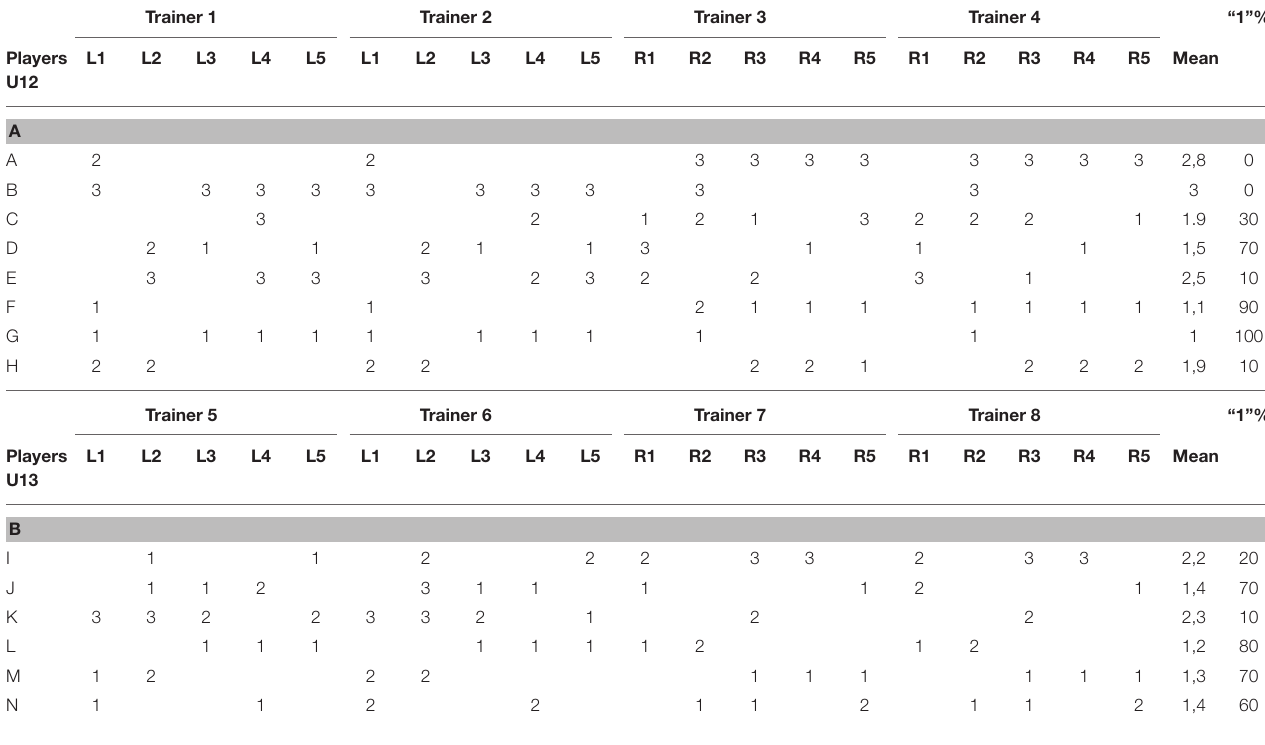
TABLE 2 | (A) Overview coach ratings U12 players. (B) Overview of coach ratings U13